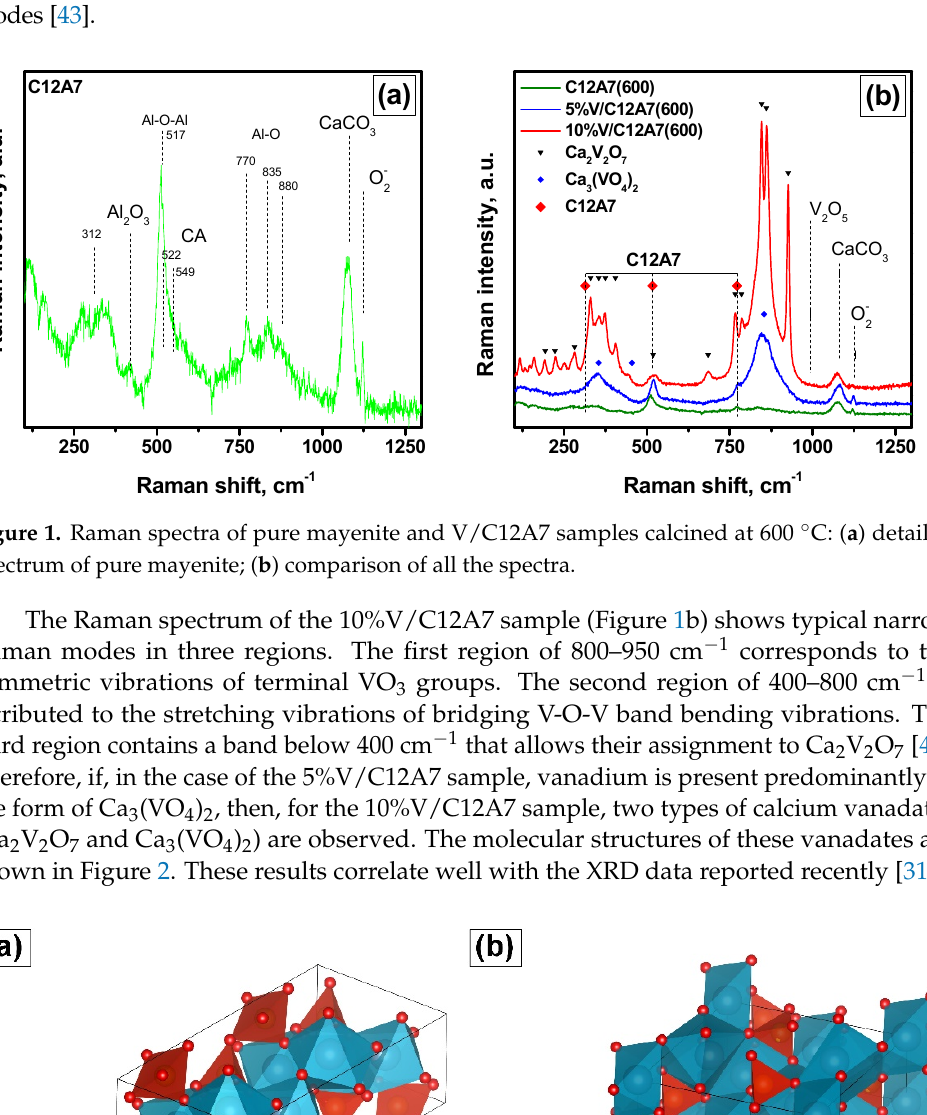
Figure 1. Raman spectra of pure mayenite and V/C12A7 samples calcined at 600 °C: ( a ) detailed spectrum of pure mayenite; ( b ) comparison of all the spectra.